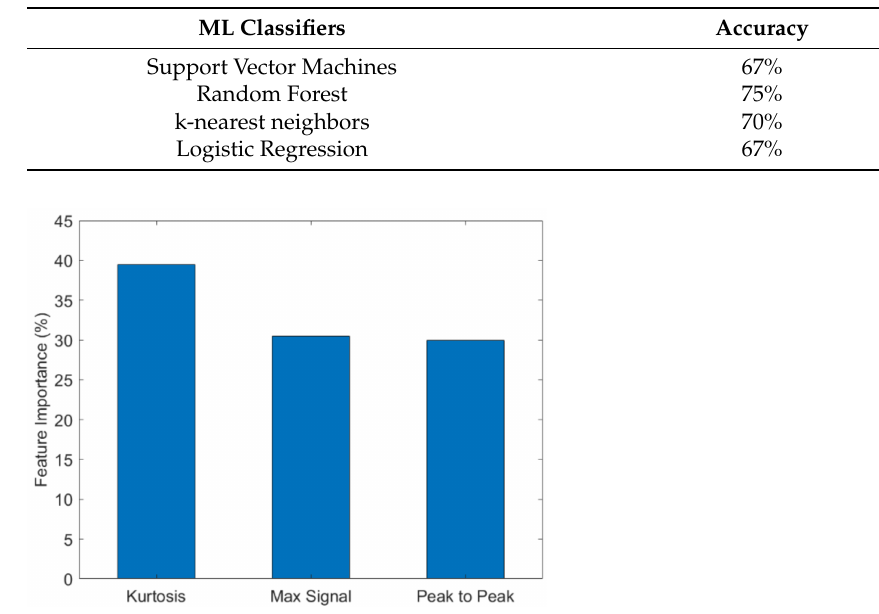
Figure 8. Change in resistance vs. concentration for mixed analytes all with Avidin capture molecule. ( A ) Biotin–Casein ( B ) Biotin–Gliadin, ( C ) Casein–Gliadin. Table 1. Classification Accuracies.